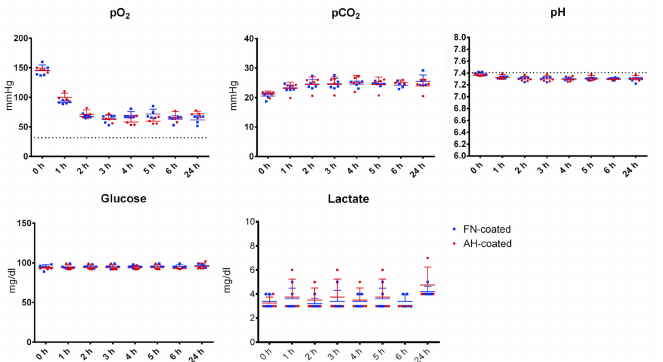
Figure 6. Medium gas analysis during flow exposure. Single point measurements of pO 2 , pCO 2 , pH, glucose, and lactate concentration during flow experiments with endothelialized AH ( red ) and FN ( blue ) coated HFM.